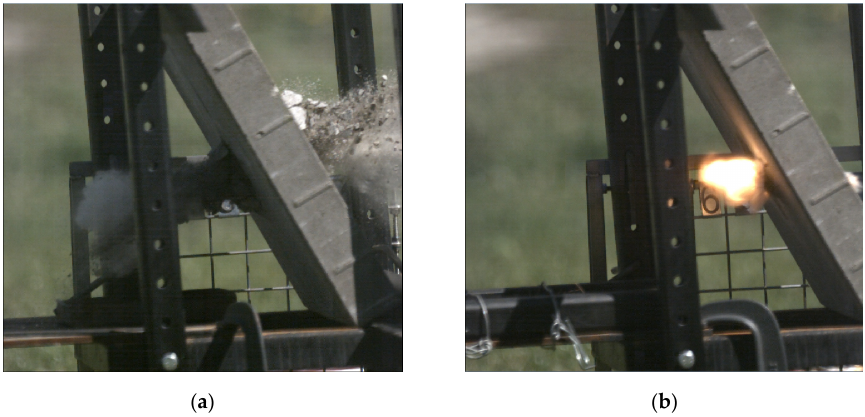
Figure 7. Recording of piercing a concrete sidewalk slab (Photron Fastcam SA ‐ Z 2100K with a speed of 50,400 fps) with the following projectiles: ( a ) 7.62 × 54R LPS; ( b ) 7.62 × 54R B ‐ 32 with a visible combustion of the projectile ignition mass.